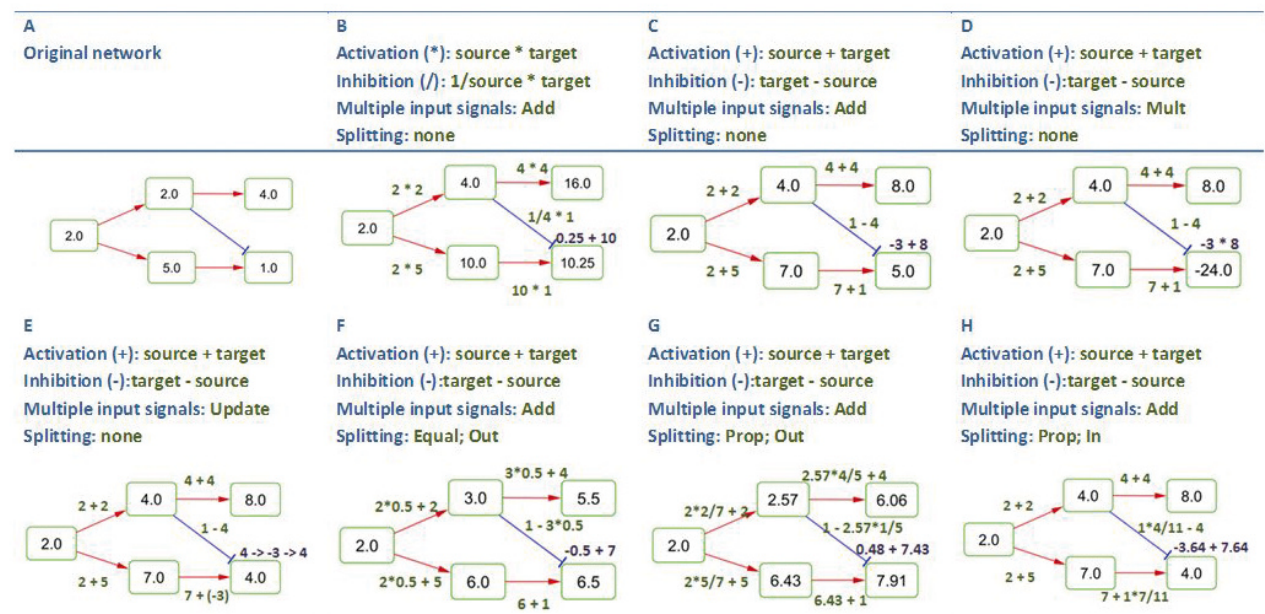
Figure 2. Demonstration of PSF computation on a sample network with different flow propagation rules. Red and blue edges are of types “activation” and “inhibition”, respectively. Multiple signals at a target node are computed by addition (Add), multiplication (Mult), or by updating target node signals (Update). Signal splitting is either set to “none” or “equal” (Equal) or “proportional” (Prop) rules, and is either performed on multiple outgoing edges (Out) or multiple incoming edges (In).